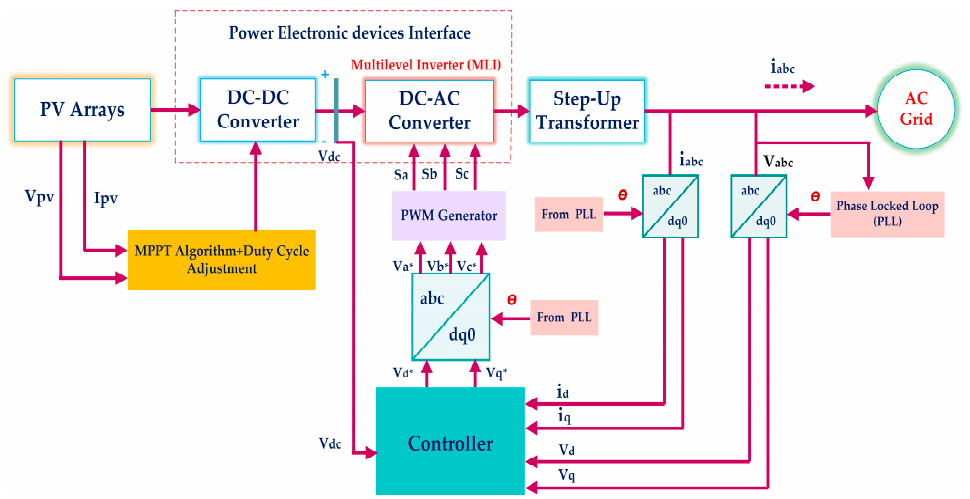
Figure 5. A general block diagram of a Grid-connected multilevel inverter for a solar photovoltaic (PV) system.